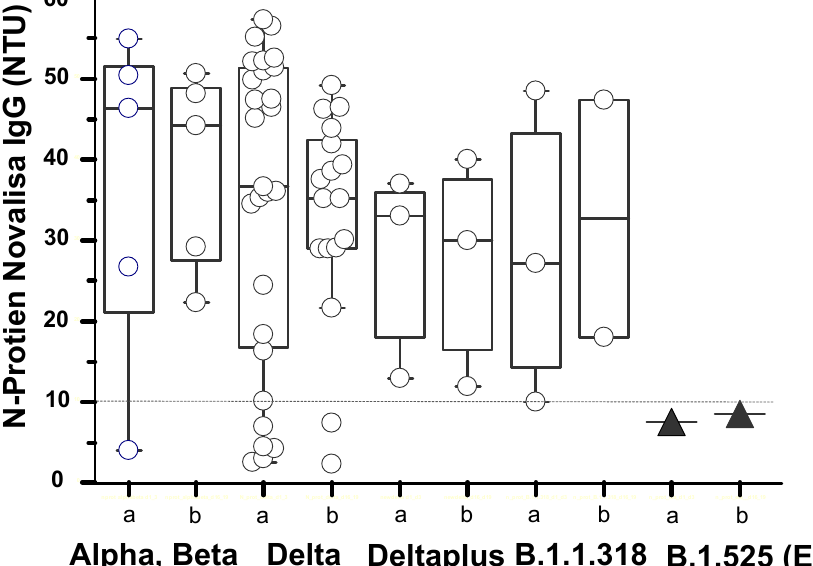
Figure 4. Anti-N-protein antibody levels of SARS-CoV-2 variants. The anti-N-protein IgG reactivity for patients infected with COVID-19 variants described in Figure 2; a = day 2 or day 3 POCS, and b = day 16 or day 17 PCOS. The horizontal dotted line indicates the cut-off for Novalisa positivity at >10